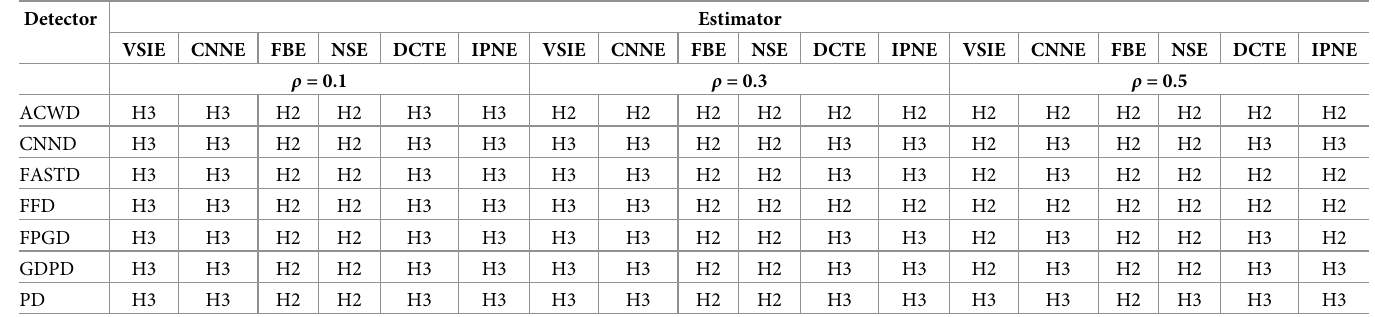
Decision made with significance level α =